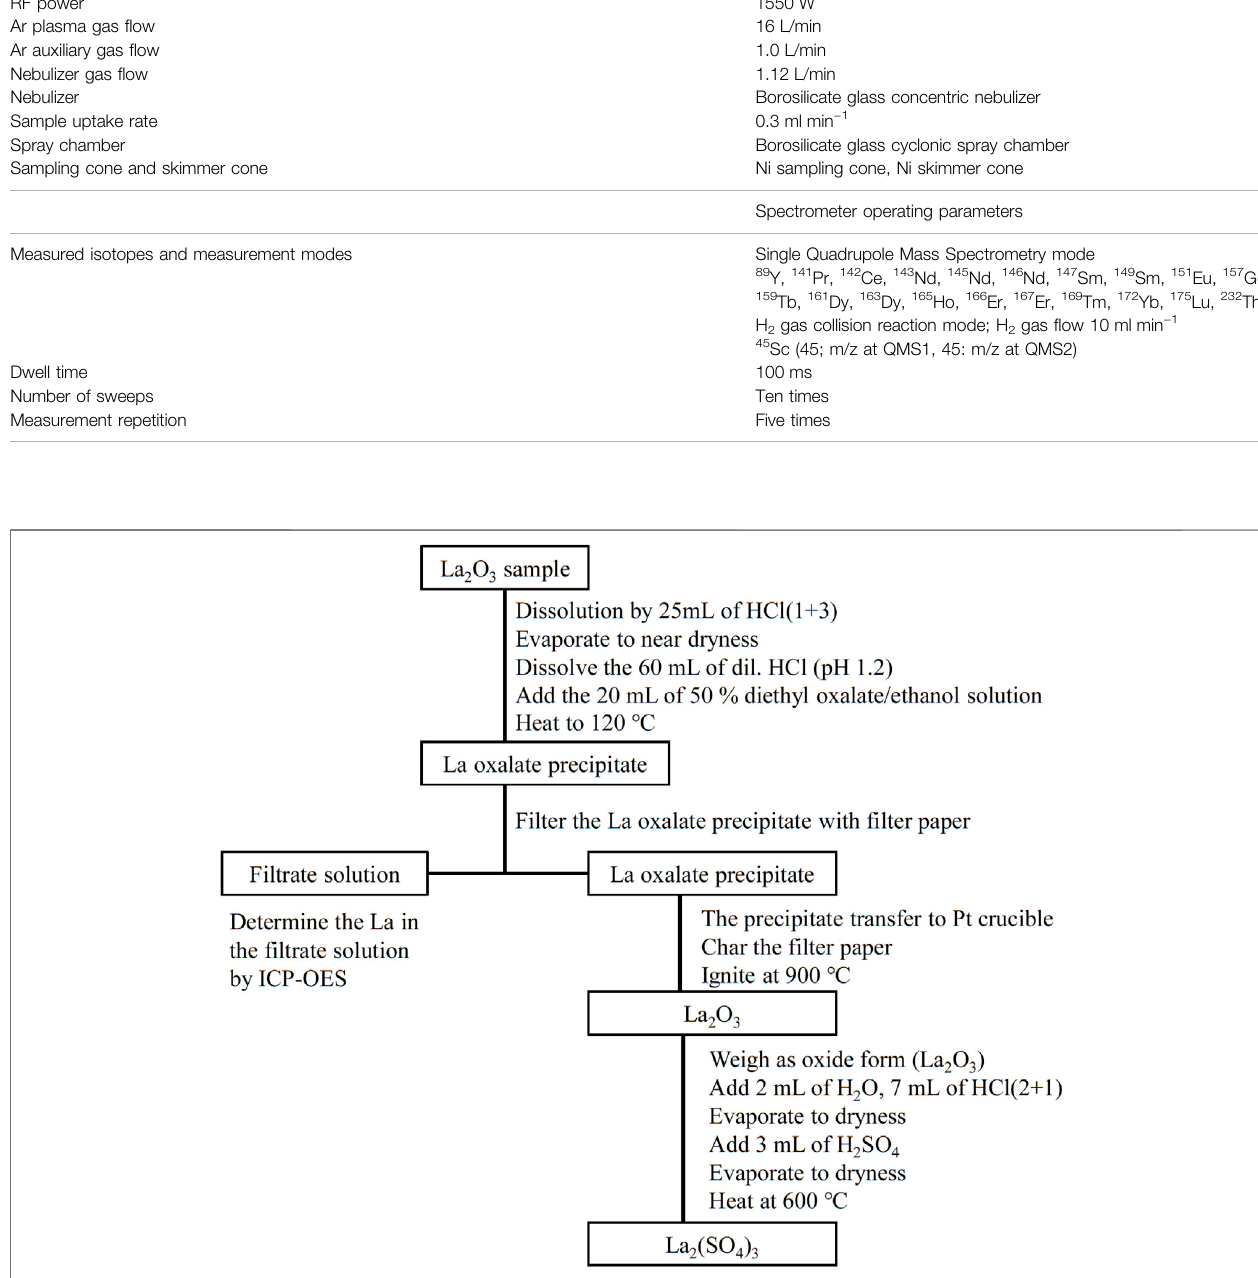
Frontiers in Chemistry |